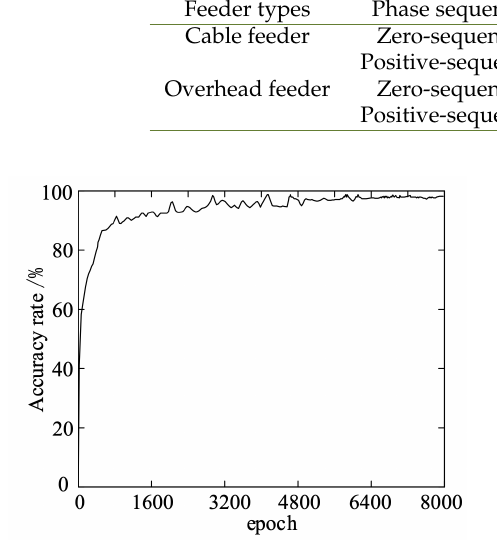
Fig. 9. Convergence curve of CNN training arranging and combining through programming algorithm, the number of training samples for all combinations is